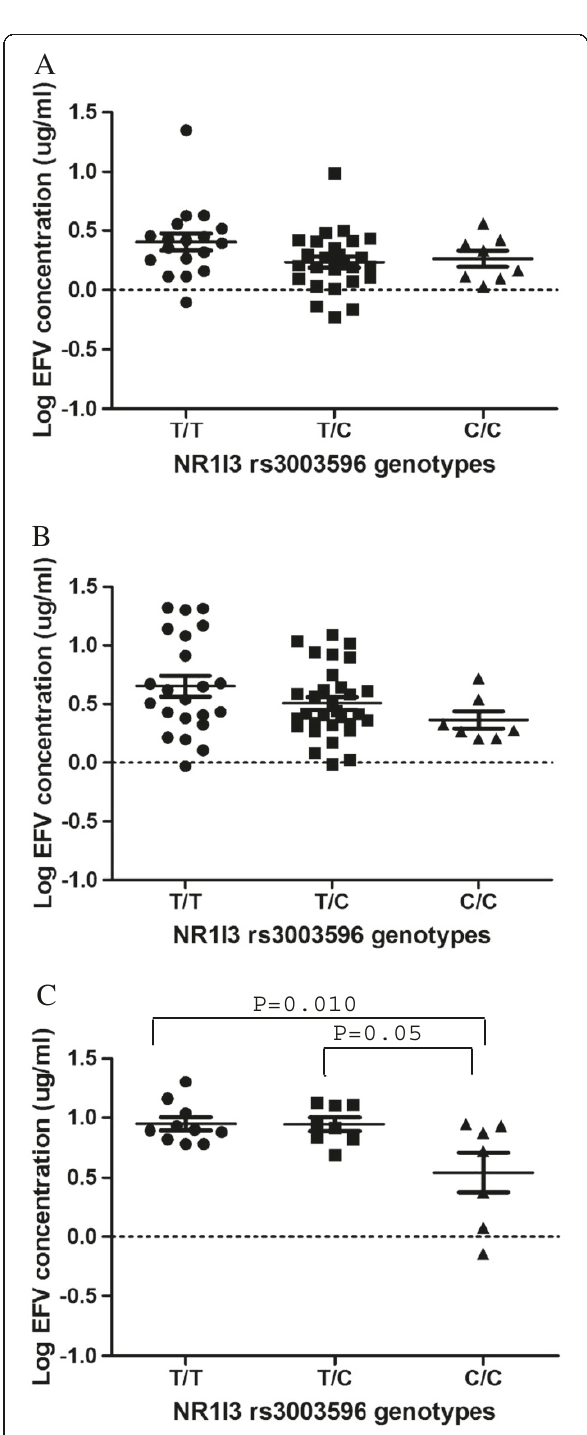
Figure 2 A-C: Effects of NR1I3 rs3003596 and CYP2B6 G516T variation on plasma efavirenz concentration. A ) NR1I3 rs3003596 stratified by CYP2B6 516G/G . B ) Stratified by CYP2B6 516G/T. C ) Stratified by CYP2B6 516T/T. Only significant P-values are